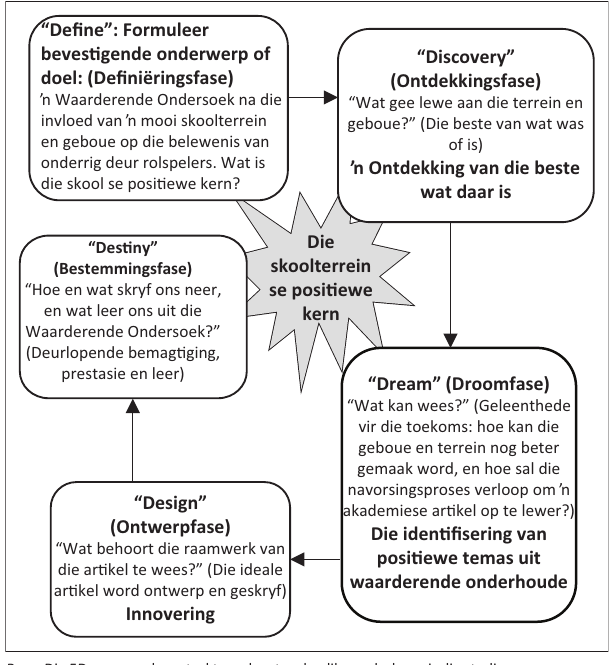
FIGUUR 3: Die skoolterrein se positiewe